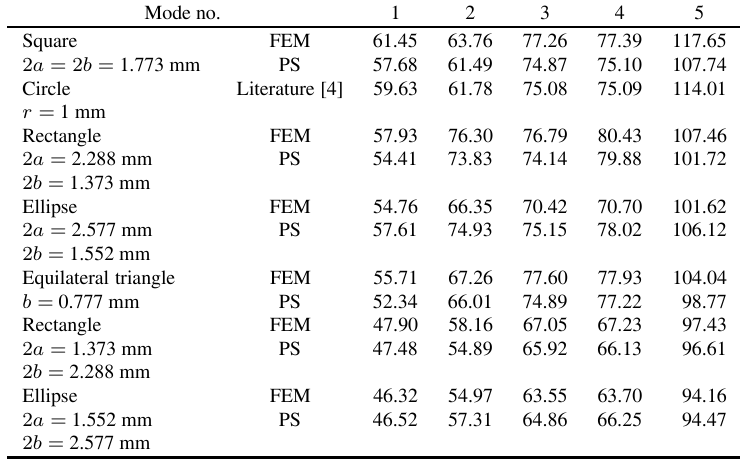
Table 6 First fi ve natural frequencies of barrel type spring with four cross-sectional shapes ( R 1